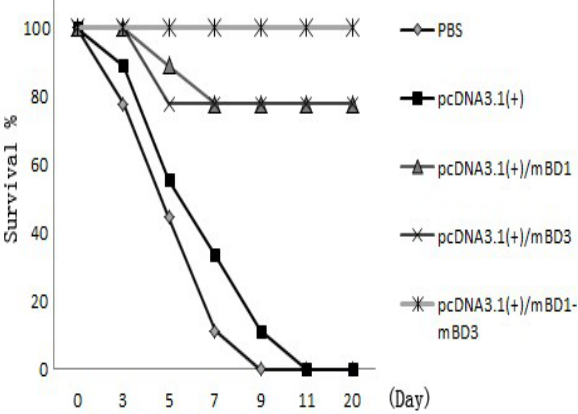
Figure 6. Survival rate after lethal challenge with A/PR/8/34(H1N1). The survival rates post-challenge with 10× LD50 A/PR/8/34(H1N1) are shown in Figure 6. No mice survived from the control groups, seven mice survived in pcDNA3.1(+)/ mBD1 group and pcDNA3.1(+)/ mBD3 group, and all the mice survived in pcDNA3.1(+)/ mBD1-mBD3 group. Significant differences in the survival rates of the three recombinant plasmid-treated groups were observed relative to the control groups ( p <